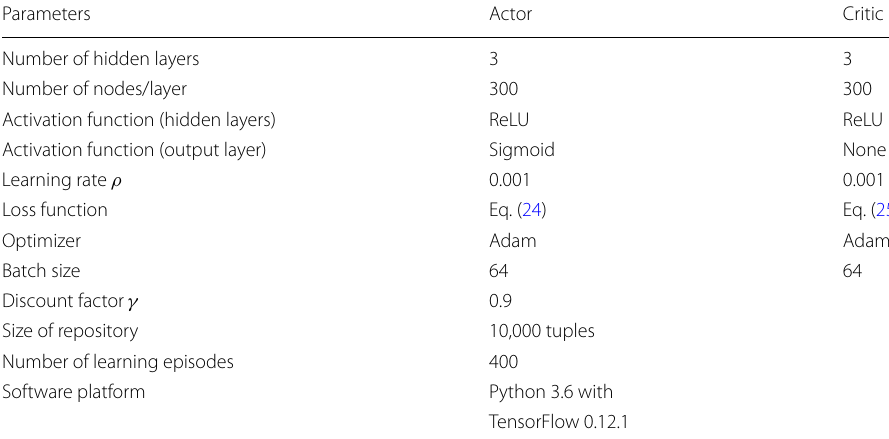
Table 2 Parameters in ACGOP and ACGP